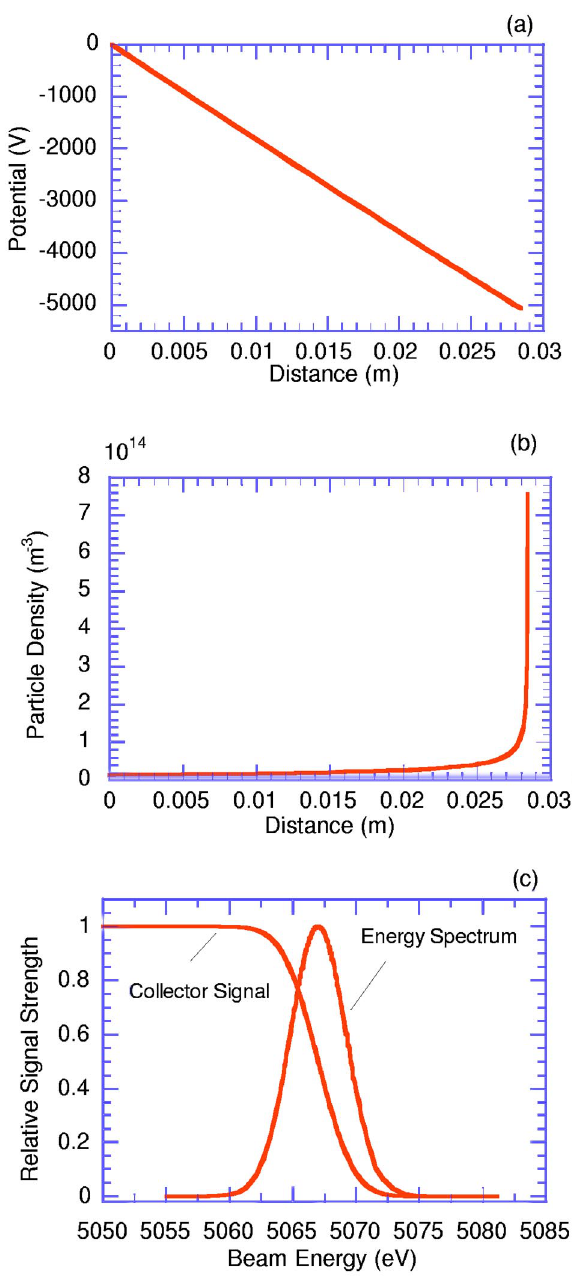
FIG. 9. (Color) Simulation of the energy analyzer performance for (cid:19) (cid:3) 0 : 062 . (a) Potential distribution with retarding voltage at (cid:7) 5067 eV . (b) Particle density distribution with retarding voltage at (cid:7) 5067 eV . (c) Energy analyzer collector signal and energy spectrum. rms energy spread of 2.2 eV, FWHM of 5.1